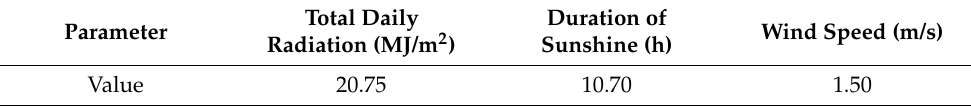
Table 4. Meteorological